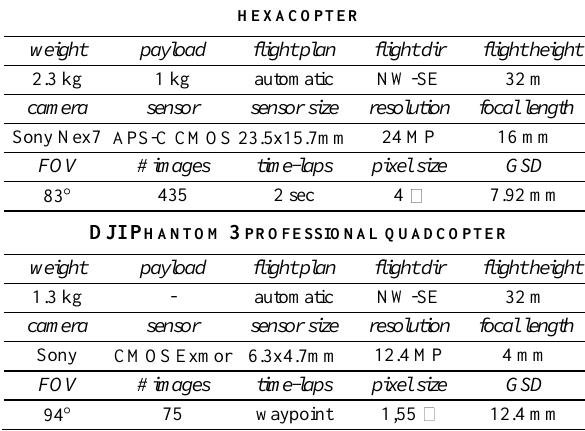
Table 1. UAVs and cameras specifications and survey